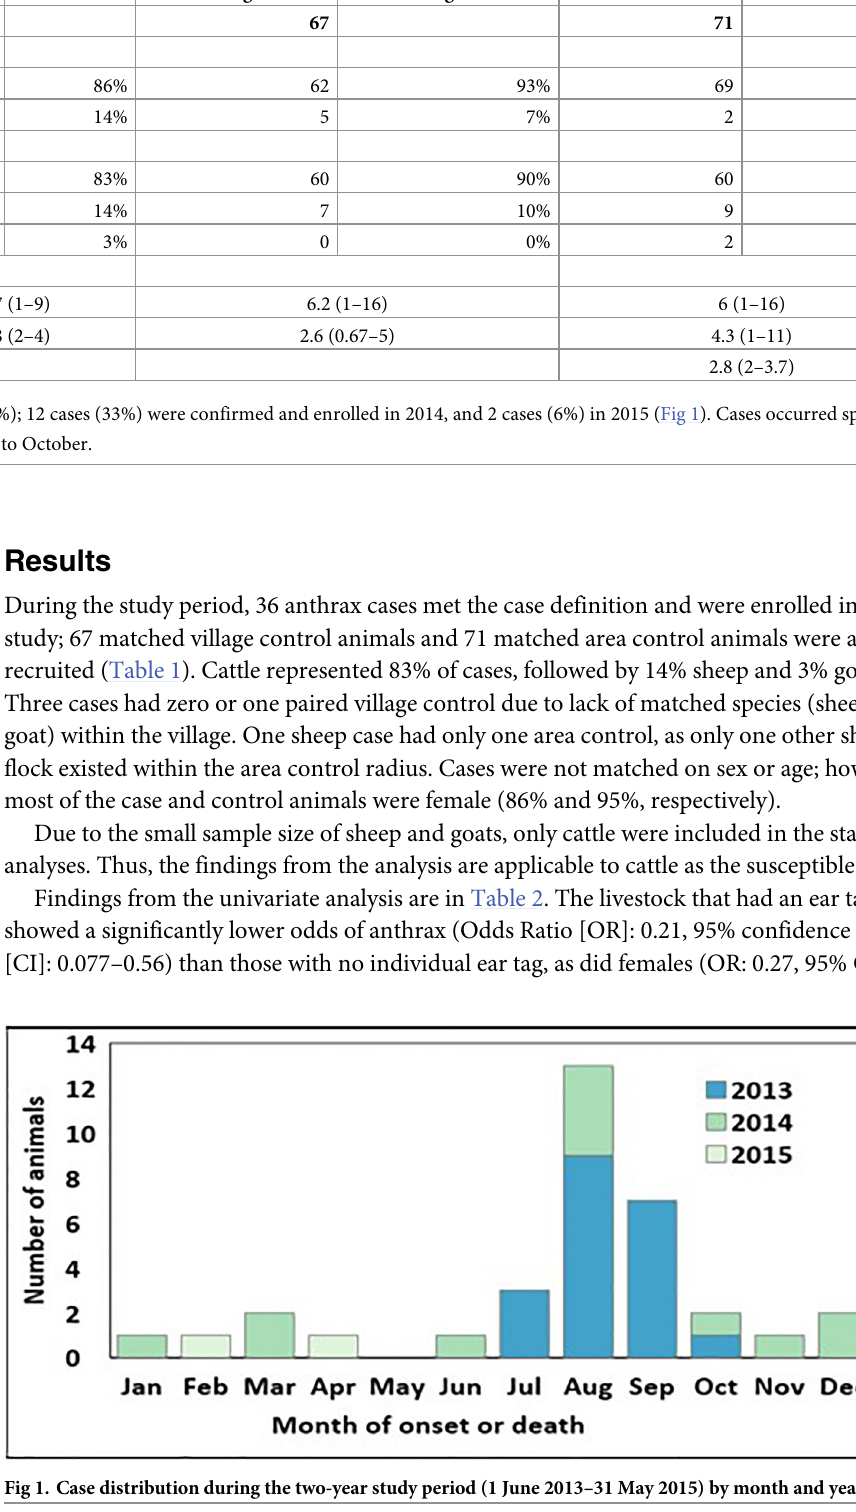
Table 1. Characteristics of the enrolled case, village control, and area control animals. Characteristic